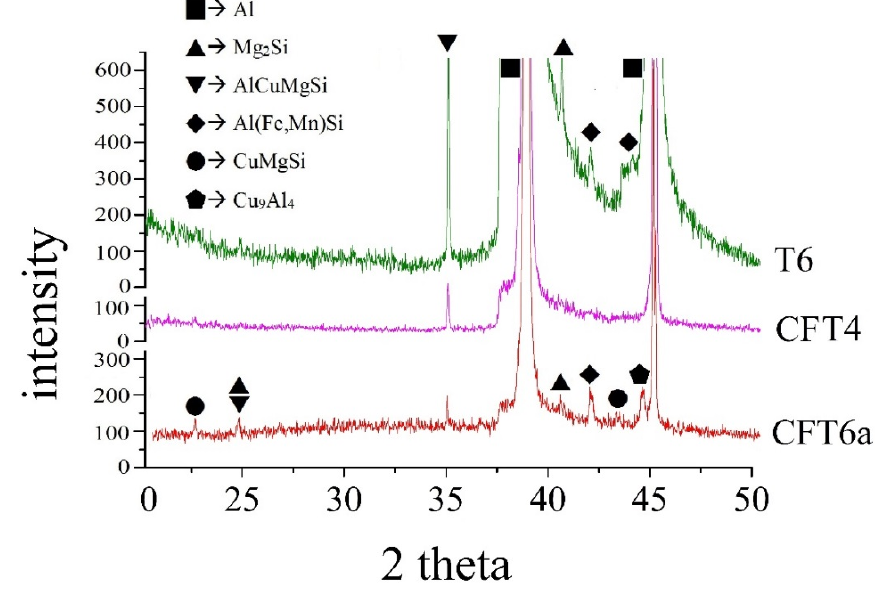
Figure 4. XRD patterns of 6066 alloy samples; including solution and aging T6 sample; cryoforged samples after solution treatment CFT4 and aging CFT6a, respectively.